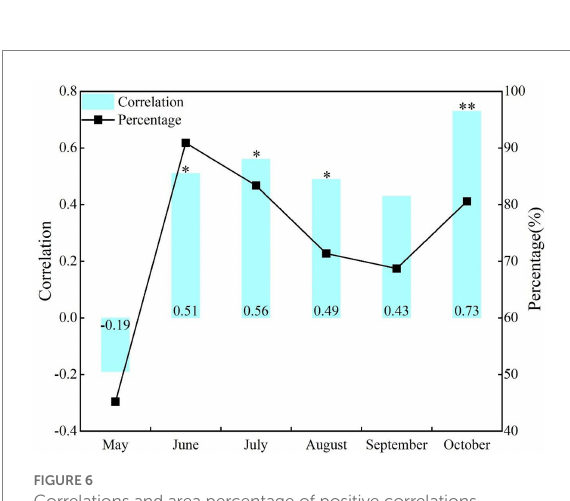
FIGURE 6 Correlations and area percentage of positive correlations between the NDVI and SPEI lagged period effect at the monthly scale.